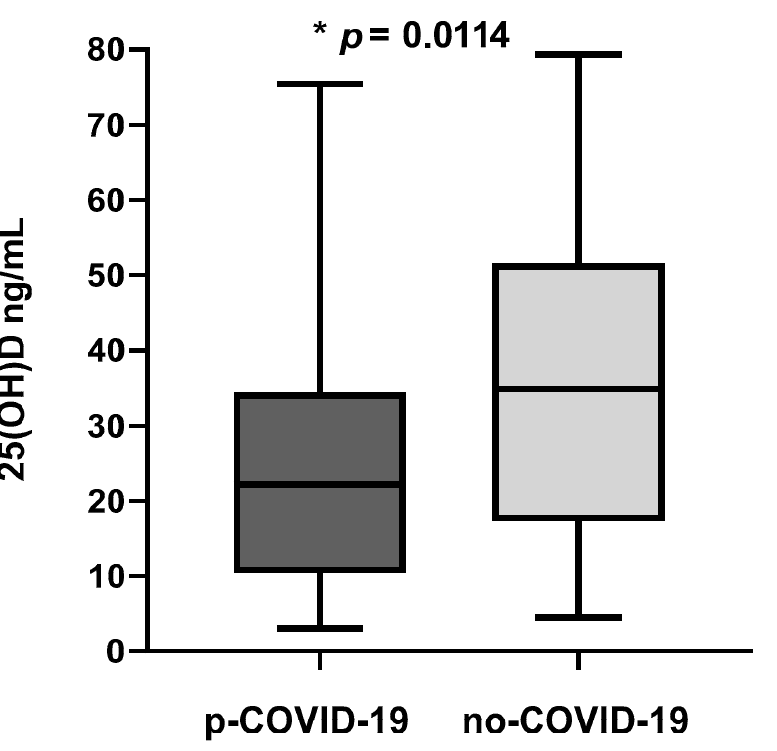
Figure 1. Plasma 25(OH)D levels in blood samples of COVID-19-positive and COVID-19-negative subjects; * p = 0.0114.